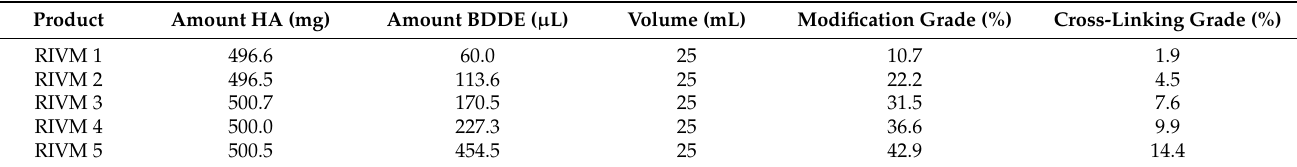
Table 7. Experimental synthesized cross-linked HA used in the biocompatibility assays. Modification and cross-linking grade were determined by